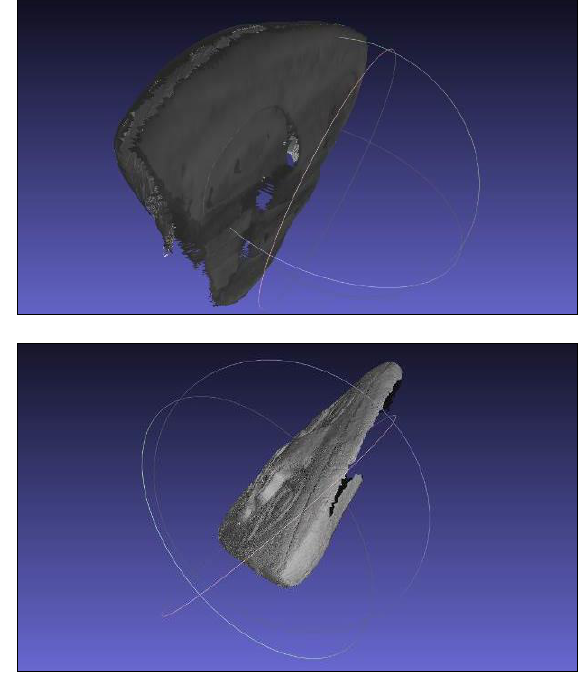
Figure 4 and 5. “Escultura 23”. Meshes showing the lack of points/polygons on the angles of the